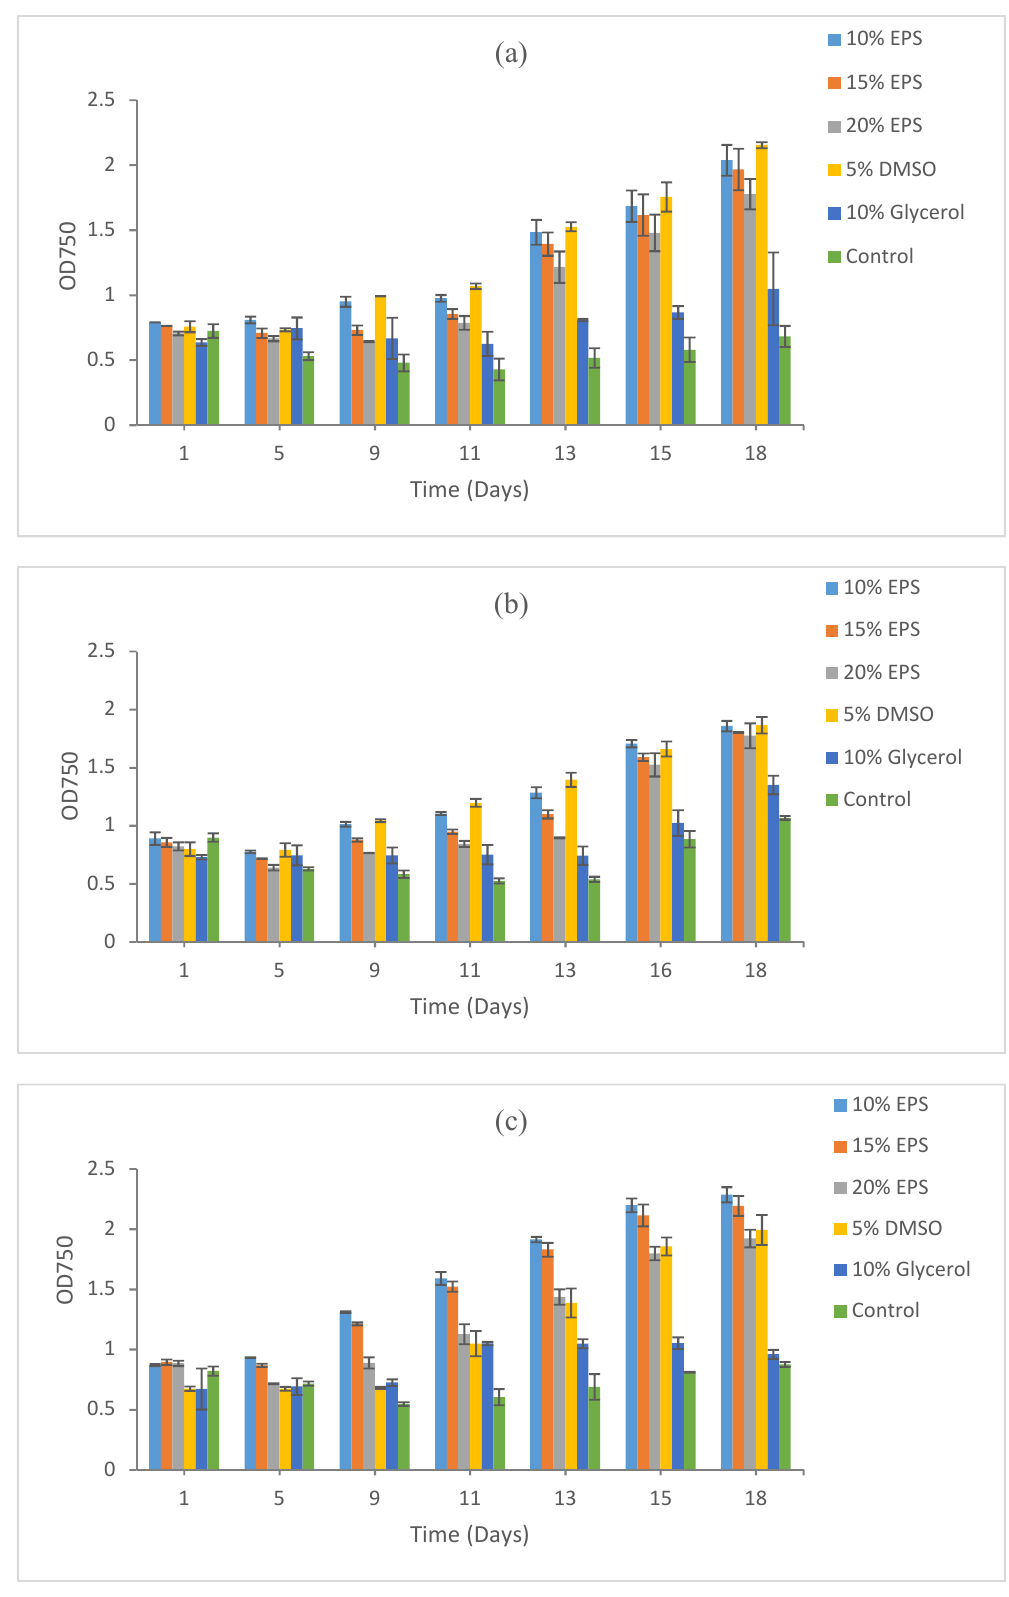
Figure 4. Growth recovery for Scenedesmus sp. HTB1 after cryopreservation for ( a ) 5 days, ( b ) 15 days, and ( c ) 9 months. The images of cultures at the end points refer to Figure S4.